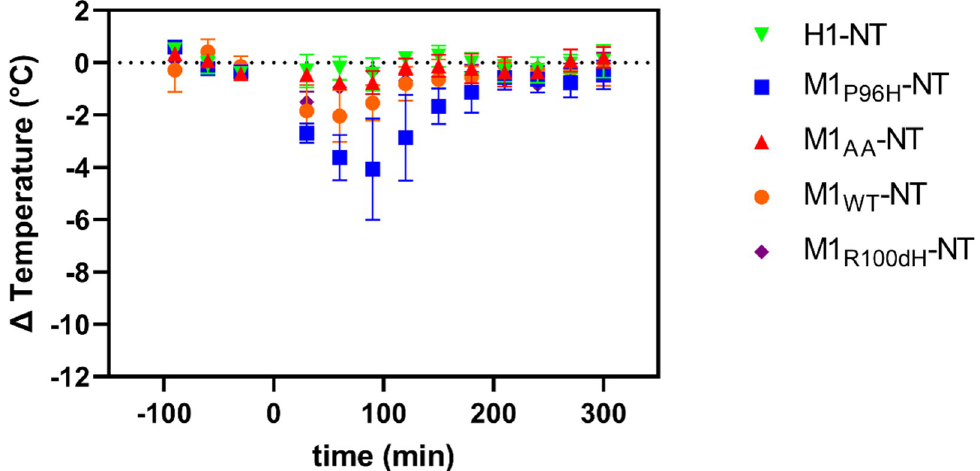
Fig 4. Hypothermic effect of M1 VHH-NT fusions in a randomized, blinded cohort. Five VHH-NT fusions M1 WT -NT, M1 P96H -NT, M1 AA -NT, M1 R100dH -NT and H1-NT were blinded by an independent investigator. Each blinded VHH-NT fusion was injected in a randomized fashion at a dose of 600nmol/kg body weight (n = 3 per group) and body temperature measured over the indicated time interval. Following complete data collection of the temperature measurements, the results were unblinded. Consistent with previous finding, M1 P96H -NT gave the most prominent hypothermia